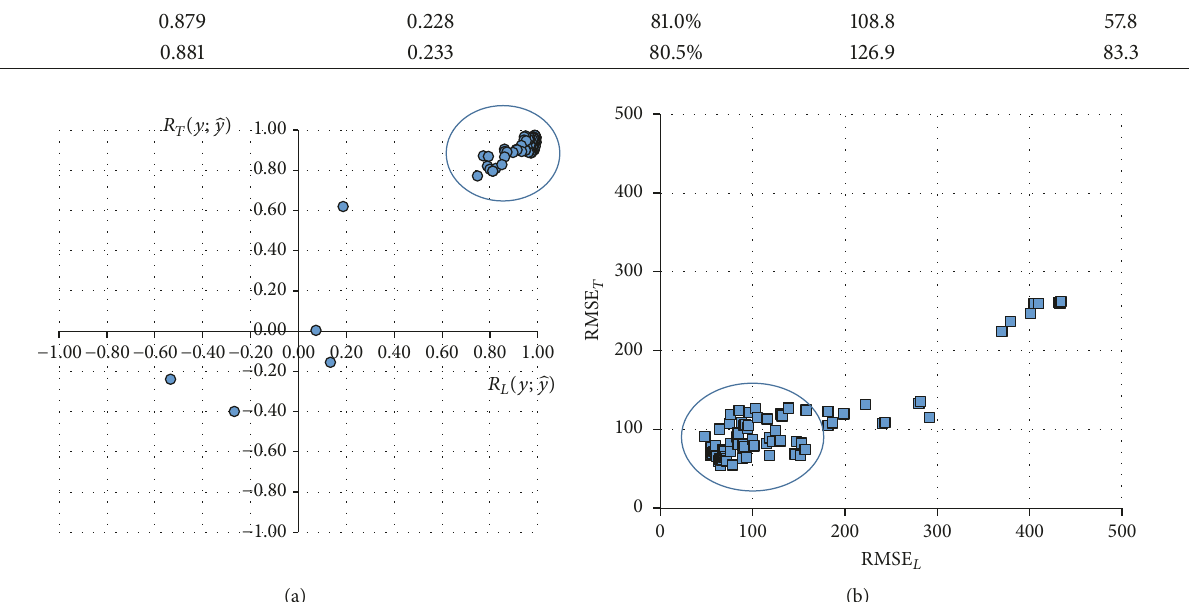
Figure 2: Quality end errors of ANNs after the initial training phase: (a) scatter diagram of Pearson’s correlation coefficients and (b) scatter diagram of errors ( RMSE ) ; 𝐿 and 𝑇 stand for learning and testing subsets accordingly (source: own study).